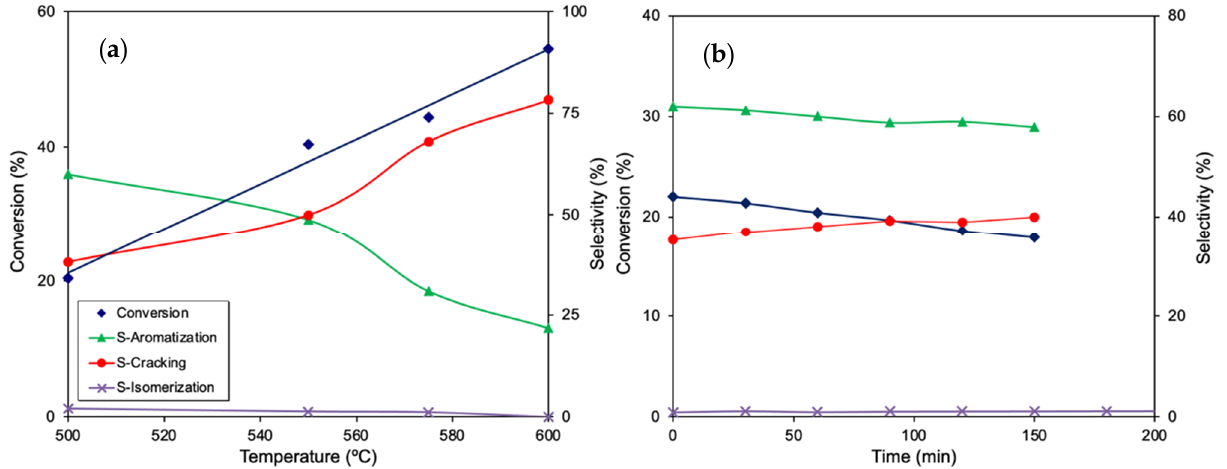
Figure 4. Evolution of conversion and products distribution for sample S7: ( a ) as a function of temperature and ( b ) as a function of time on stream at 500 °C.